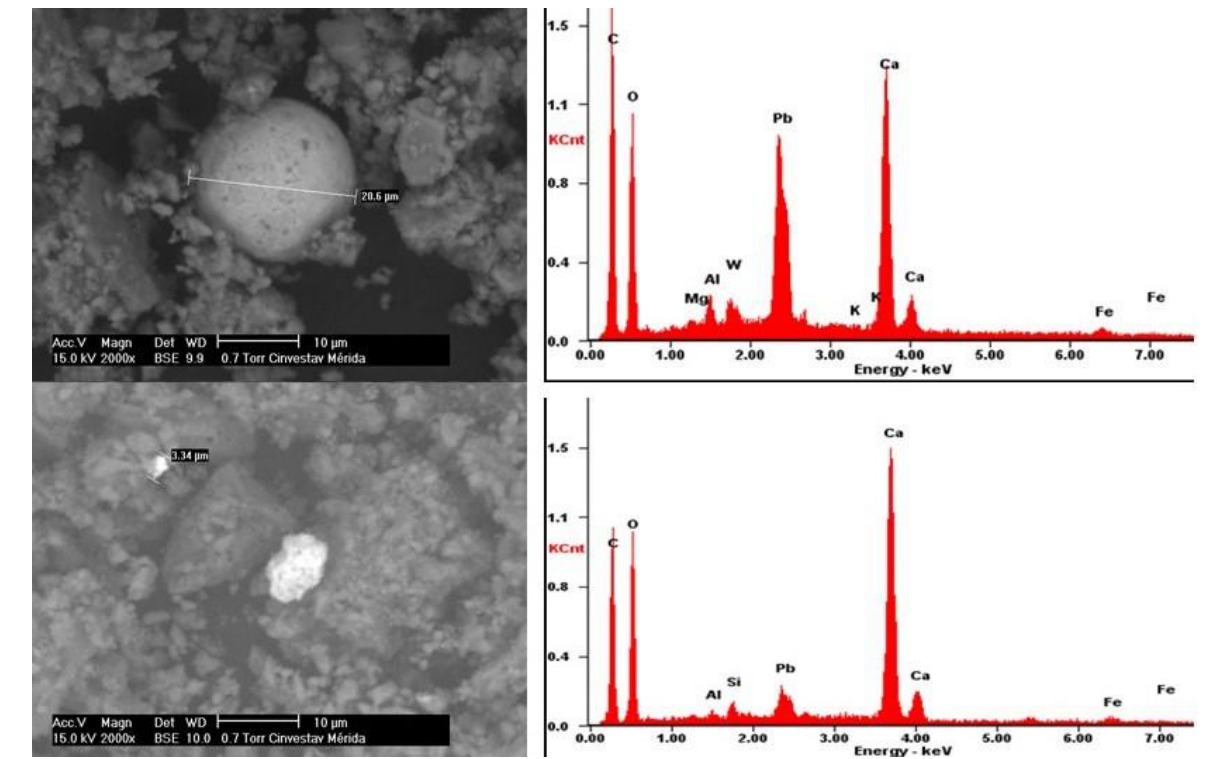
Figure 7. Anthropogenic particles in road dust.